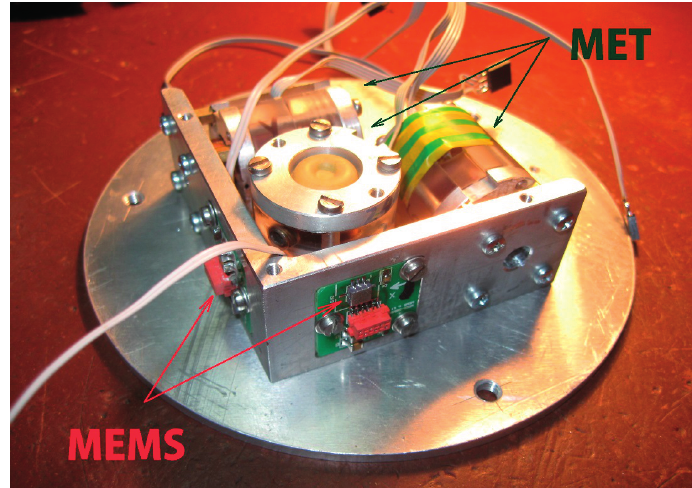
Figure 10. Sensing elements of the combined sensor.